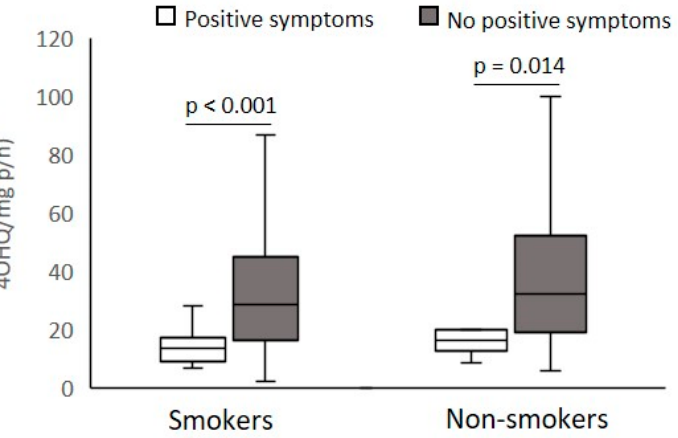
Figure 2. Platelet MAO-B activity in subjects with mild, moderate, and severe PTSD symptoms sub- divided according to smoking status.